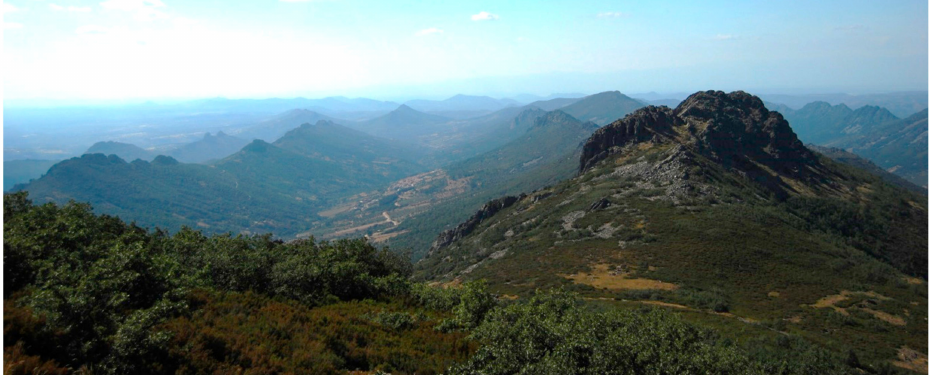
Figure 3. Iso-altitudinal ridge crests. Source: author’s own